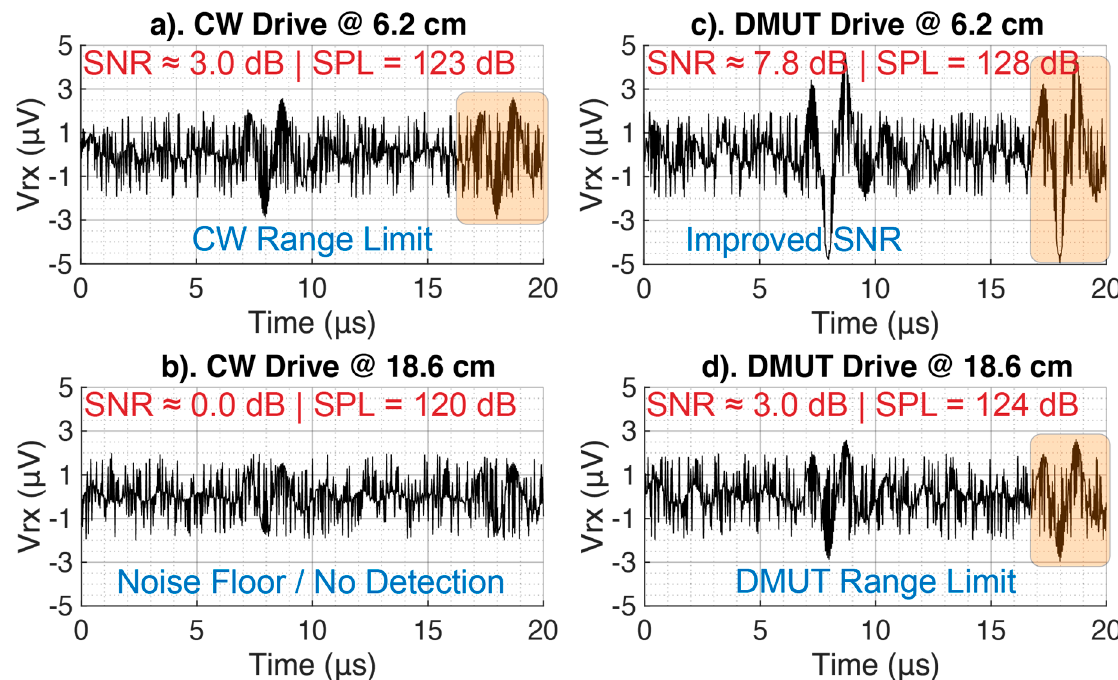
Figure 14. Measurement results in a water tank. Received signal captured by a Teledyne hydrophone with − 228 dB re 1 V/ μ Pa corresponding to a noise floor of NF = 4 μ Pa. Both systems are driven with the same energy levels. ( a ) CW drive at 6.3 cm corresponding to the maximum reachable distance where the SNR is at least 3 dB. ( b ) CW drive at 18.6 cm where the SNR is 0 dB, and the signal is not detectable from the noise. ( c ) DMUT drive at the same distance as in ( a ); this new drive approach shows an improvement of the SNR from 3 dB to 7.8 dB for same input energy level. ( d ) DMUT drive at the same distance as in ( b ); this new drive approach shows an improvement of the SNR from 0 dB to 3 dB allowing, extending the communication link from 6.2 cm, which is the maximum limit for the CW drive as shown in ( a ), to 18.6 cm, which is the maximum limit for the DMUT drive as shown in ( d ), for the same input energy level.